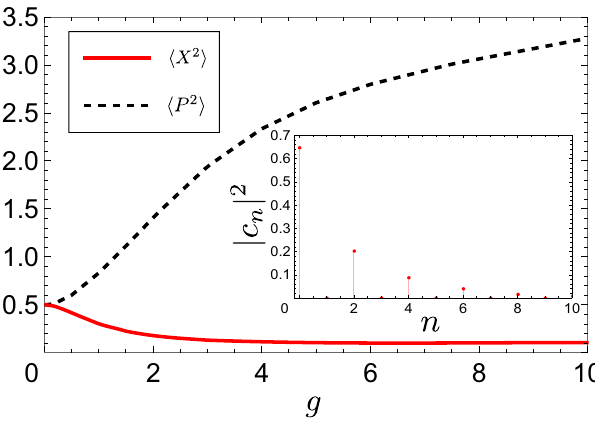
Fig. 4 Properties of photonic states coupled to the Su-Schrieffer-Heeger chain. Expectation values 〈 X 2 〉 (red solid line) and 〈 P 2 〉 (black dashed line) as a function of the light-matter coupling g for the intercell hopping w = 1. In the absence of the coupling between the cavity and the Su-Schrieffer- Heeger chain, the expectation values are equal, 〈 X 2 〉 = 〈 P 2 〉 = 1/2. For fi nite values of g , 〈 X 2 〉 decreases and 〈 P 2 〉 increases with increasing g , and photonic state becomes squeezed. Inset: Photon probability density ∣ c n ∣ 2 as a function of photon number n for g = 10. Other parameters are chosen as number of unit cells L = 100, lattice constant a 0 = 1, intracell hopping v = 1, cavity frequency ω c = 0.5, and maximum number of photons N max =